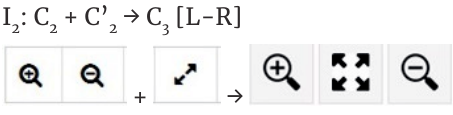
→ zero The zoom group (C ) joined the reset size/position (C’ 2 top-centre